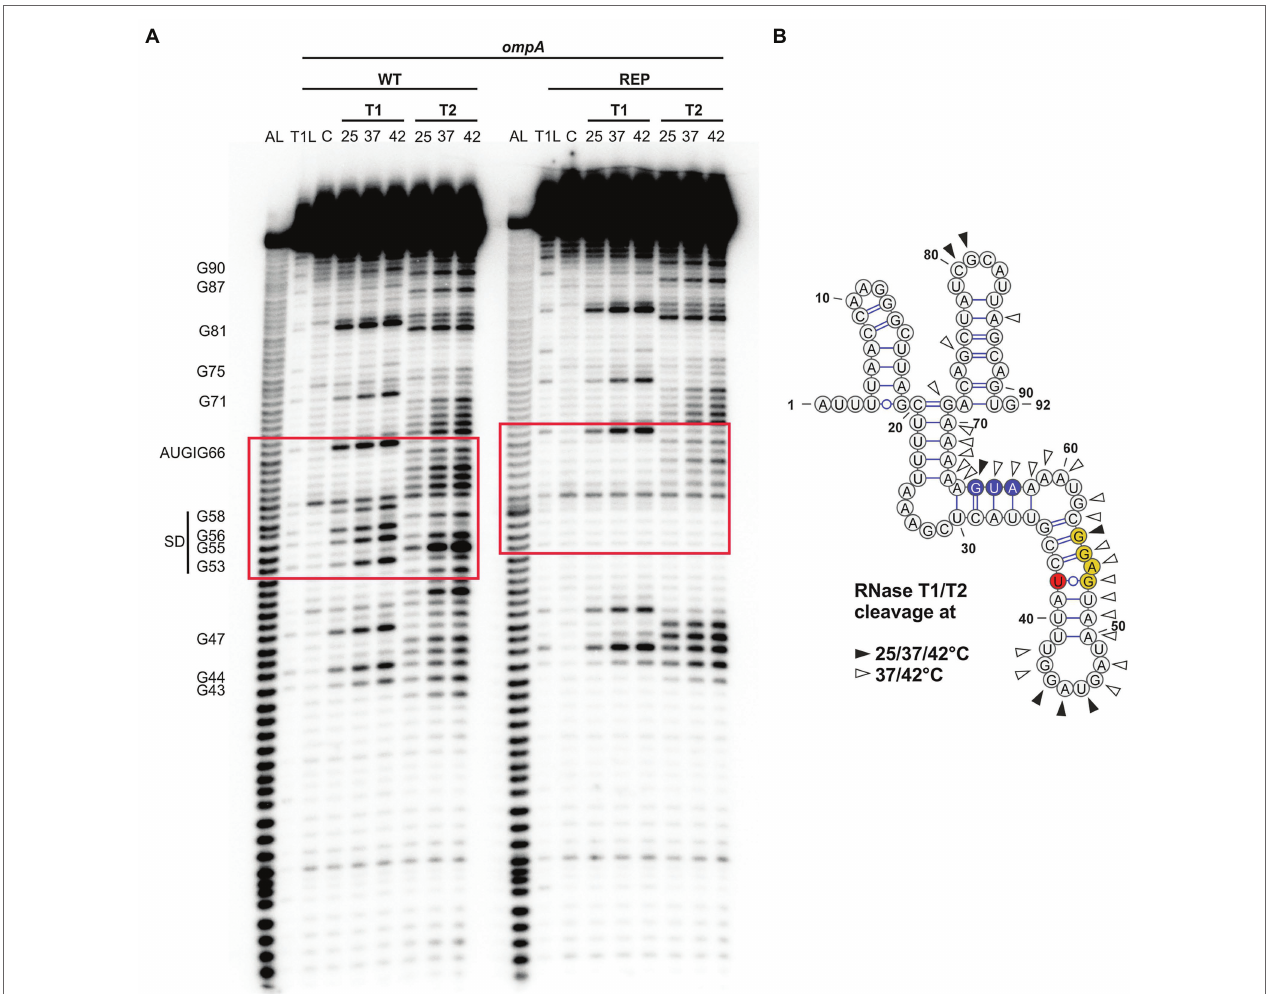
FIGURE 3 | Accessibility of the ribosome-binding site of ompA is increased at higher temperatures. (A) Enzymatic structure probing of the ompA RNAT (WT) and its stabilized version (REP) at 25, 37, and 42 ° C. In vitro transcribed RNA was 5' -[ 32 P] labeled and treated with RNases T1 and T2, respectively. AL, alkaline ladder; T1L, RNase T1 cleavage ladder in sequencing buffer at 37 ° C; C, RNA treated with water instead of RNases – cleavage control. Ribosome-binding site is highlighted by a red box. Experiment was carried out at least three times. (B) PARS-derived secondary structure of the ompA RNAT at 25 ° C. The potential SD sequence is highlighted in yellow, the mutation site of the anti-SD sequence in red, and the AUG in blue. Distinctive nucleotide cleavage is indicated by black and white